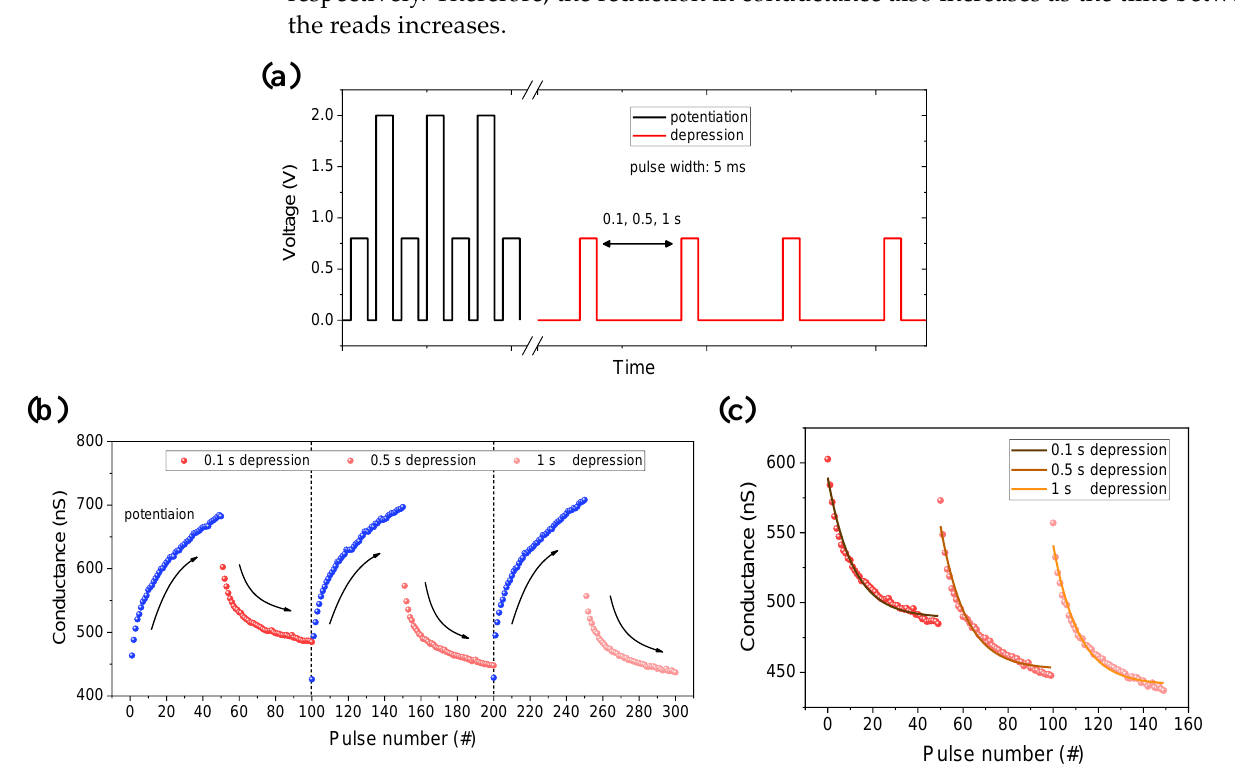
Figure 5. ( a ) An input pulse schematic for potentiation and depression. The potentiation pulses (black) are designed so that the pulse width is 5 ms and amplitude 2 V. The depression pulses (red) show the read pulse of 0.8 V that the interval time is only different by 0.1, 0.5, 1 s. ( b ) The conductance change of potentiation (blue)/depression (red). ( c ) A graph of the 0.1, 0.5, 1 s depression area fitting by the equation, respectively.